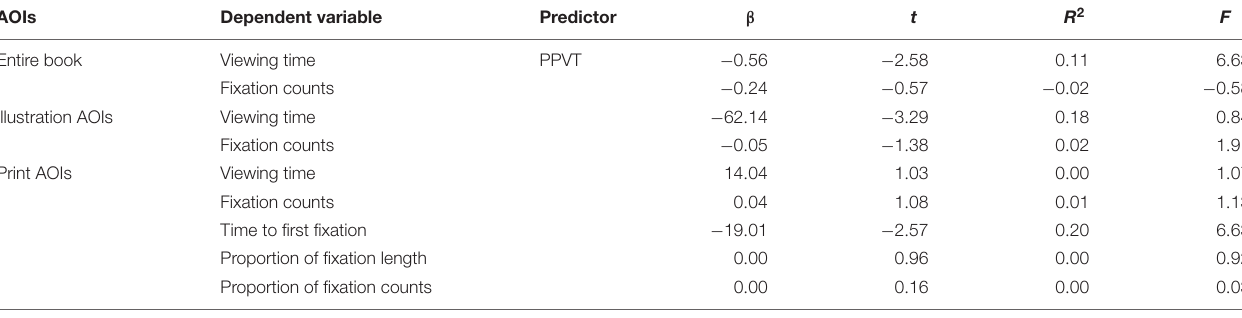
TABLE 2 | Summary of regressions predicting reading skills.